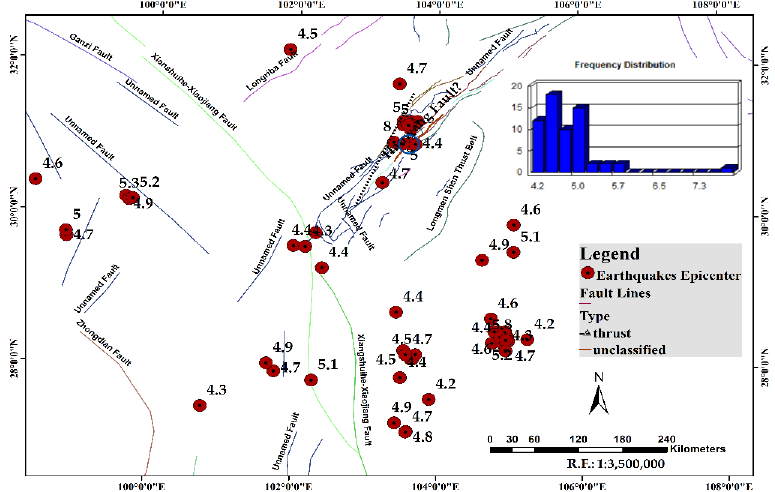
Figure 2. Location of earthquake points in DCEN; earthquake points are represented with red dot circles and crisscrossed fault lines are displayed in the map (data extracted, point plotting, and mapping exercise performed in the ArcGIS 10.6 software environment); the temporal earthquake epicenter data points are considered from 12 May 2008 to 8 September 2019. The inset image shows frequency of earthquakes in different magnitudes that struck in the DCEN and its vicinity areas.